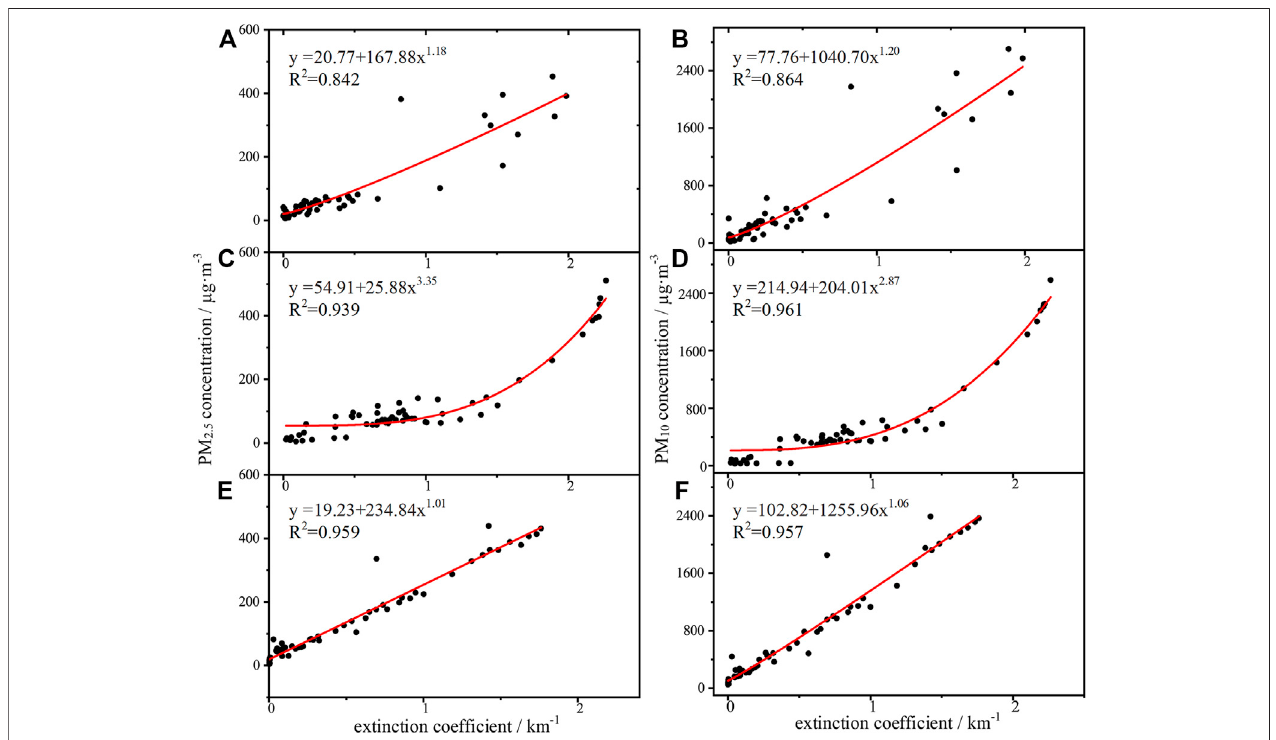
FIGURE 5 | Relationship between the extinction coef fi cient and PM 2.5 (left panel), PM 10 (right panel) concentration monitored on the ground (from top to bottom: Wuwei (A,B) , Baiyin (C,D) , and Dingxi (E,F) .